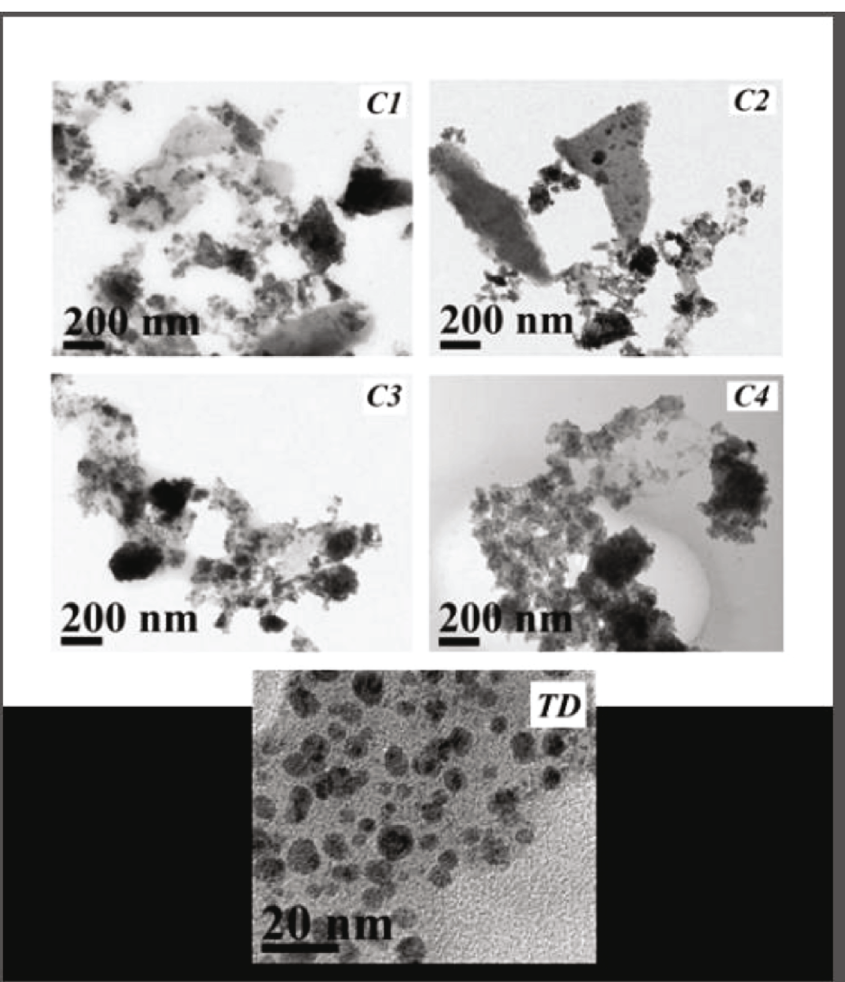
Figure 2: TEM images of composite materials C1 to C4 and nanoparticles of TD.